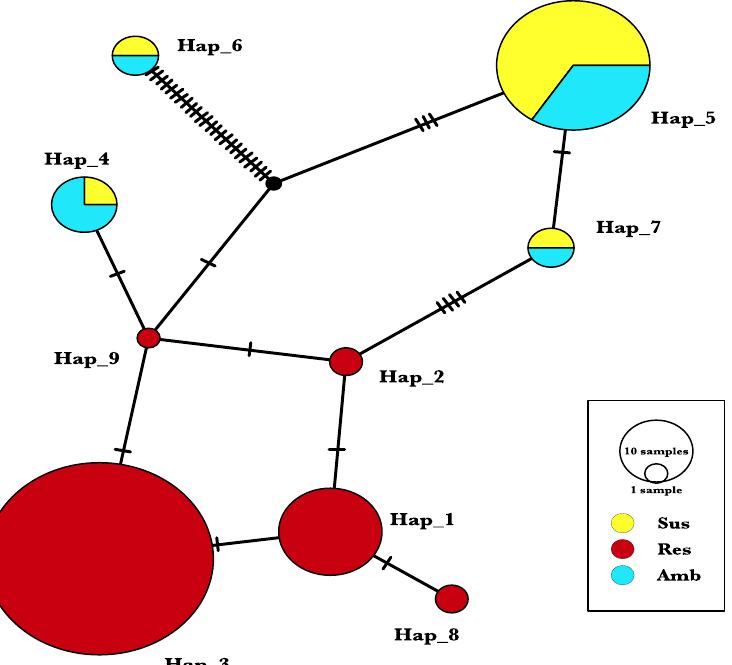
Figure 2. Haplotype analysis of the ALS gene. All weedy rice samples are grouped into nine haplotype groups. Sus: IMI-susceptible weedy rice; Res: IMI-resistant weedy rice; Amb: IMI-R ambiguous weedy rice.